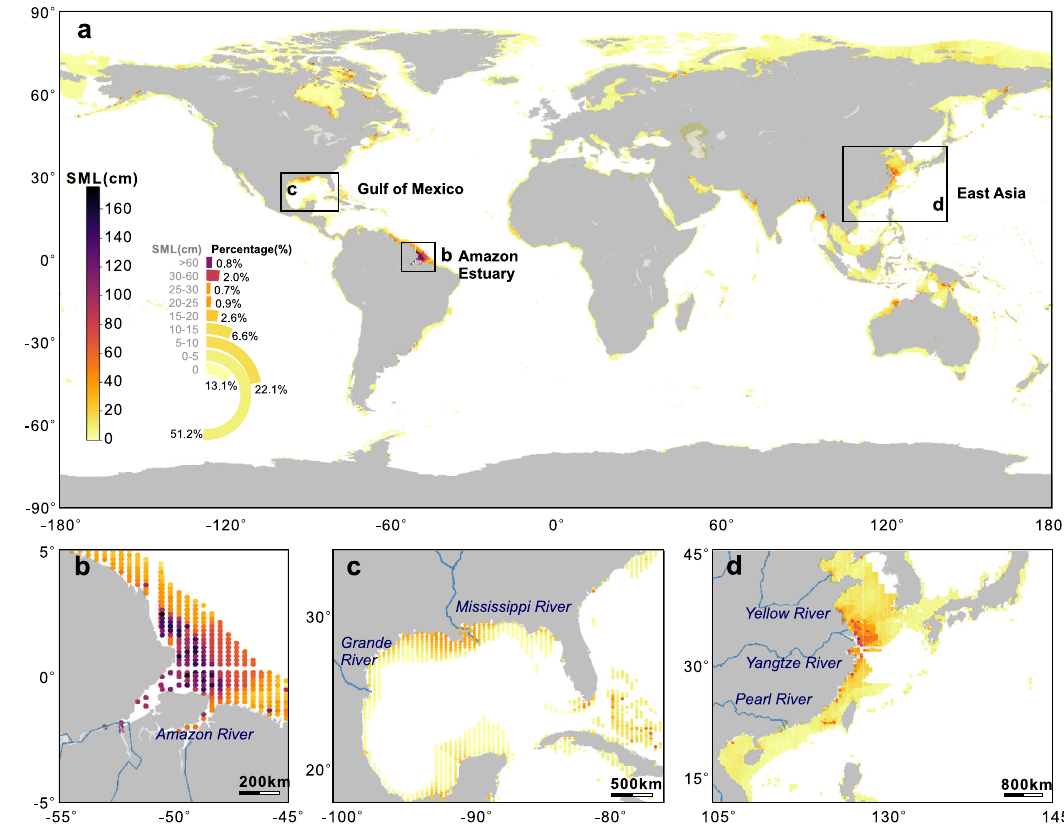
Fig.3|Simulationofsedimentmixedlayer(SML)thicknesses.a Theglobalcoastalocean; b TheAmazonEstuary; c GulfofMexico;and d ThecoastaloceanofEastAsia. Maps generated with python3-mpltoolkits.basemap (version 1.2.1,